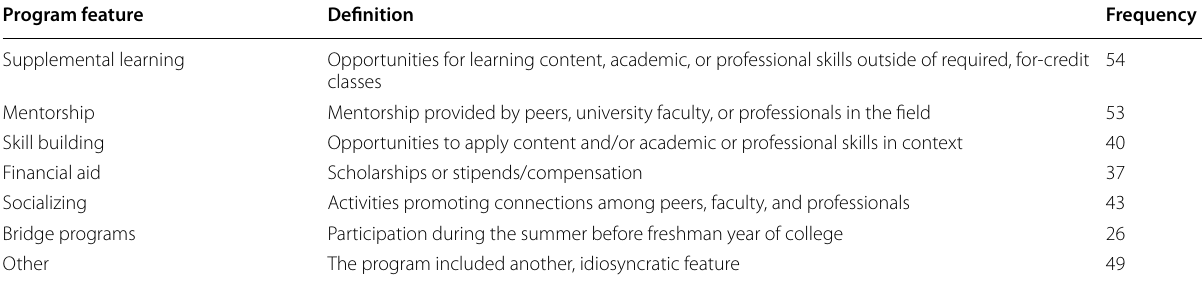
Table 5 Common program features in the